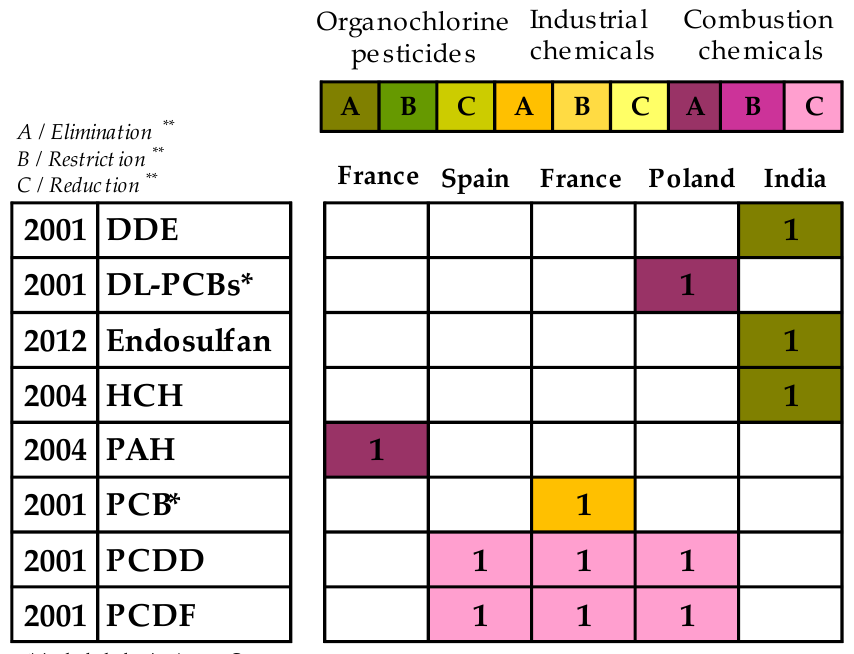
Figure 1. POPs presence in feed (including the number of reporting articles). Classification conducted in relation to the measures applied by the Stockholm Convention (**). The dates on the Y axis indicates the year when the chemical compound was included in one of the annexes of the Stockholm Convention. Some POPs are part of Annex A and also of Annex C